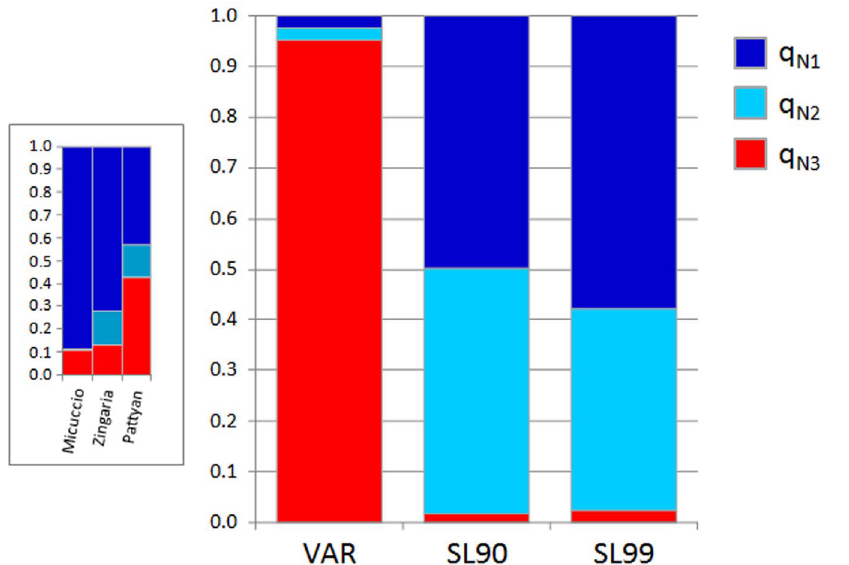
Figure 2. Membership percentages for the SL and VAR population groups, using neutral dataset markers. For VAR, the three varieties considered as controls (Micuccio, Zingaria and Pattyan, showing genotypes from Italian landrace population in their pedigrees) were excluded and their membership percentages are shown separately in the box on the left. q N1 , neutral dataset membership to cluster 1; q N2 , neutral dataset membership to cluster 2; q N3 , neutral dataset membership to cluster 3.